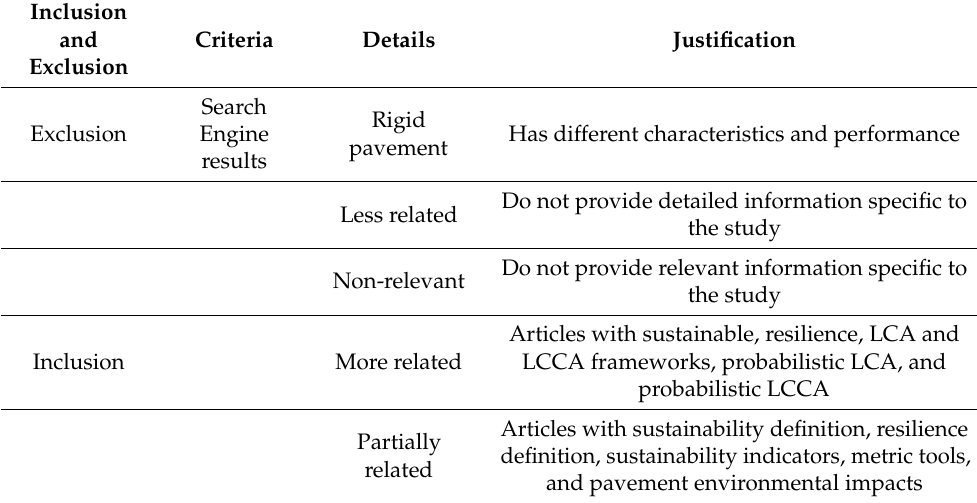
Table 1. Inclusion and exclusion